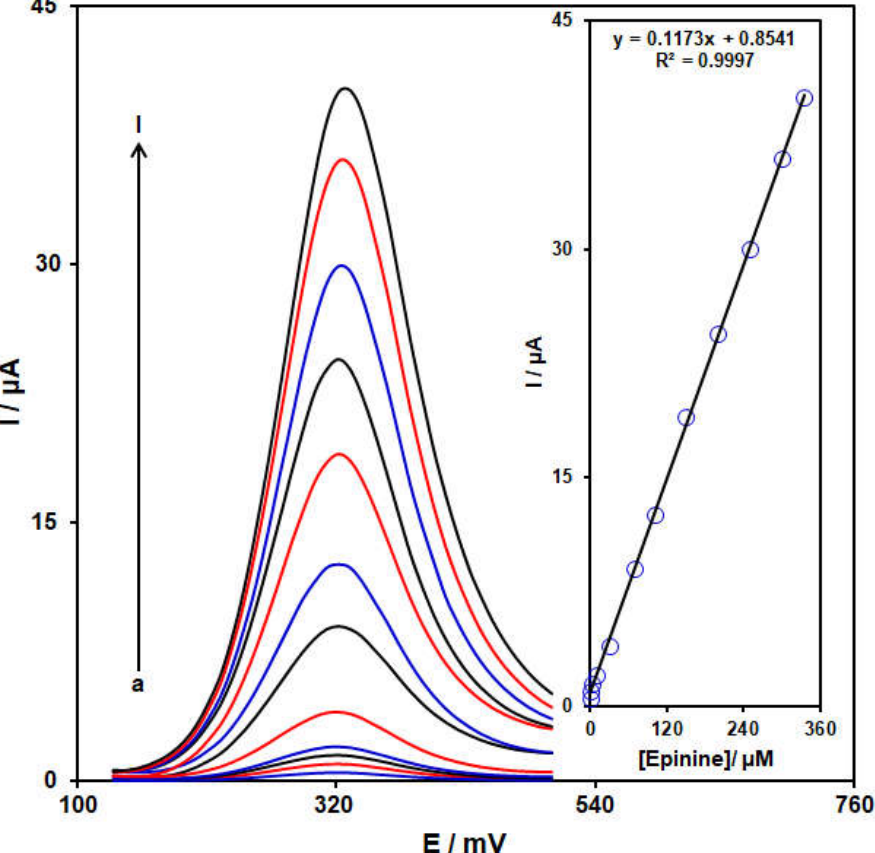
Figure 9. Differential pulse voltammograms captured for the NiCo-MOF/SPGE in the exposure to variable epinine concentrations, a–l correspond to (a) 0.07, (b) 0.5, (c) 2.5, (d) 10.0, (e) 30.0, (f) 70.0, (g) 100.0, (h) 150.0, (i) 200.0, (j) 250.0, (k) 300.0, and (l) 335.0 µM epinine in PBS (pH 7.0, 0.1 M). Insets: Relationships between the Ipa and levels of epinine.